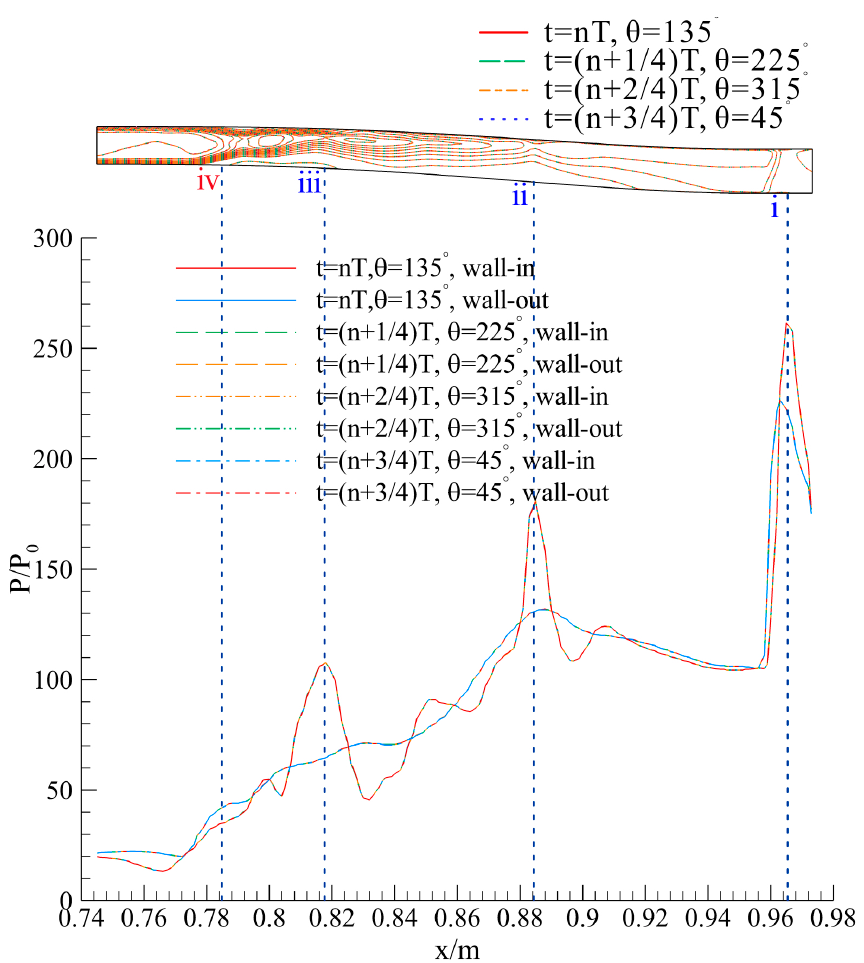
Figure 18. Feedback pressure change curve with time, where points A 1 , B 1 , C 1, and D 1 denote the meridian plane with θ = 135°, 225°, 315°, and 45° at t = n T successively, point B 2 denotes that with θ = 225° at t = (n + 0.25) T , point C 2 denotes that with θ = 315° at t = (n + 0.5) T , and point D 2 denotes that with θ = 45° at t = (n + 0.75) T .